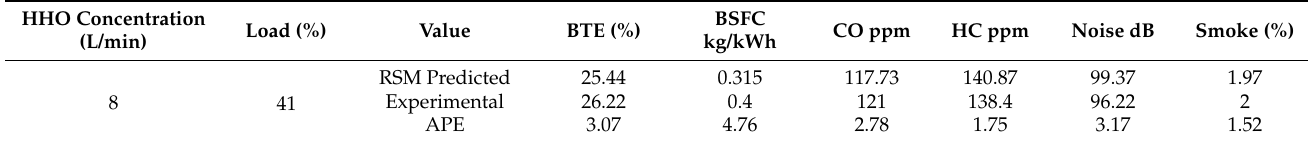
Table 16. Comparison of RSM and experimental